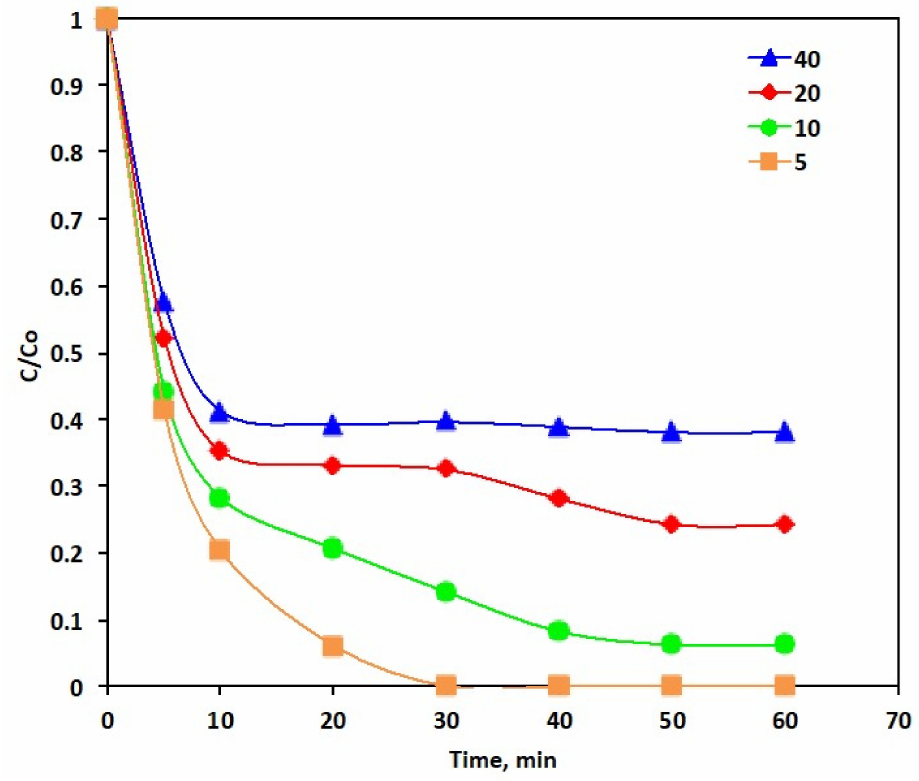
Figure 6. Effect of the initial Reactive Blue 4 loading on the PANI-MWCNTs system (Experimental conditions: PANI-MWCNTs: